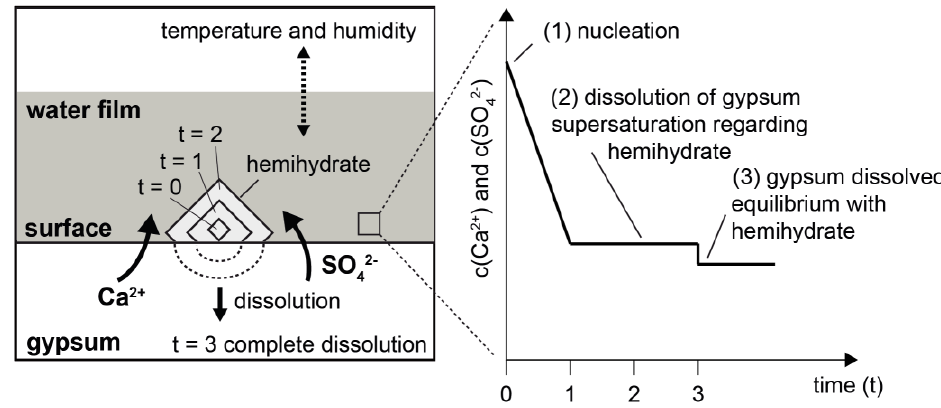
Figure 10. Model for the mechanism of the conversion of gypsum into hemihydrate.